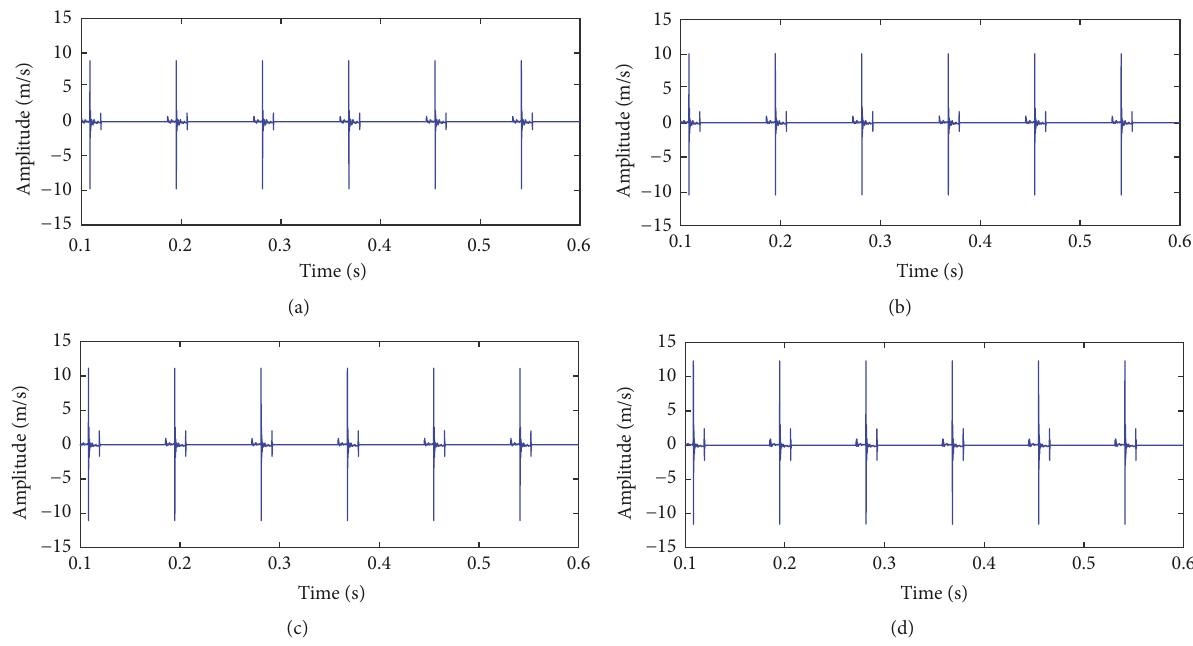
Figure 14: Velocities of the balls in the radial direction in the defect area under different loads: (a) 4.9 N, (b) 9.8 N, (c) 14.7N, and (d) 19.6 N.